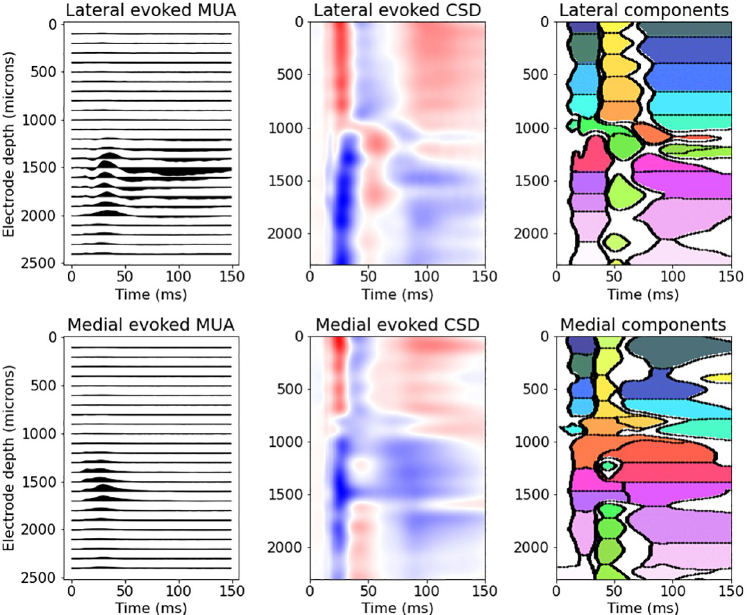
Fig 4. Estimated CSD evoked response components. Left to right: Trial-averaged multi-unit activity (MUA) relative to baseline, estimated CSD evoked response, components returned by the image segmentation (colors correspond to arbitrary cluster number). Top row corresponds to the lateral probe and bottom row to the medial probe. The evoked responses for both probes have similar features but slightly different spatial and temporal properties. In particular, both the MUA and CSD evoked responses indicate that the evoked response begins earlier in the medial probe than the lateral probe.